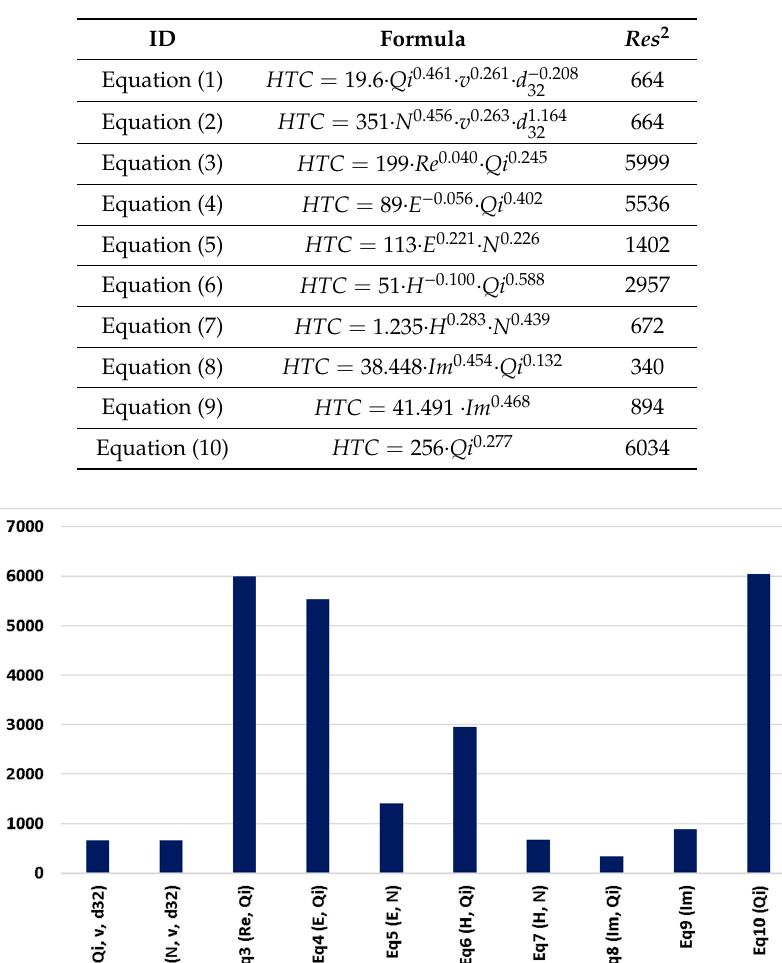
Table 2. List of tested correlations.